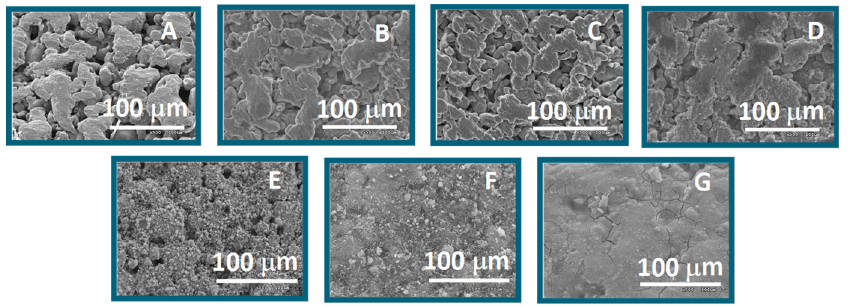
Figure 3. XRD patterns of bare PSS and PSS substrates after oxidation at 600, 700 and 800 °C, respectively.